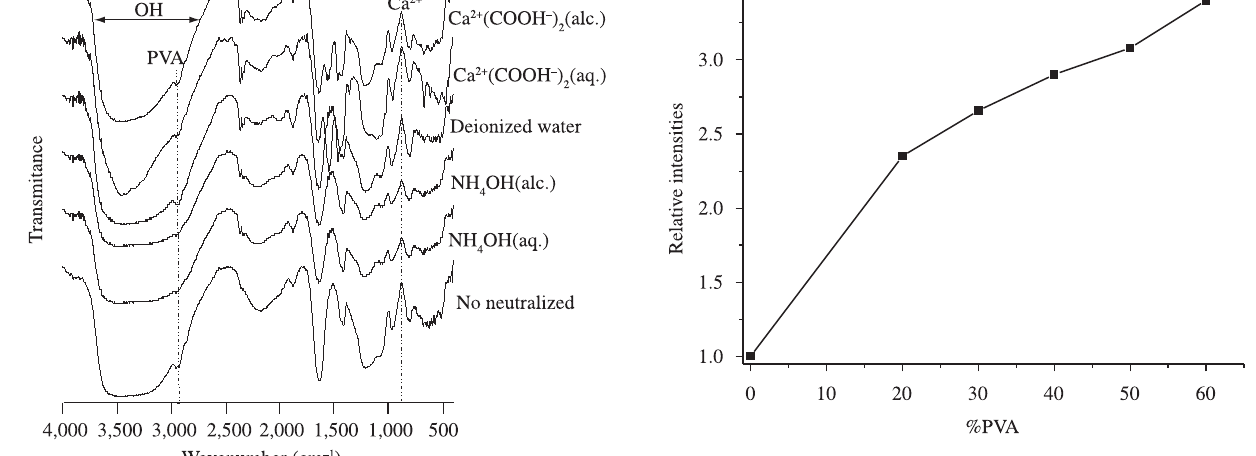
Figure 4. Relative intensities of the 830-760 cm –1 IR band of the hybrids with 20 to 60% PVA. The IR intensities for bioactive glass (0% PVA) and PVA (100% PVA) were showed as reference.